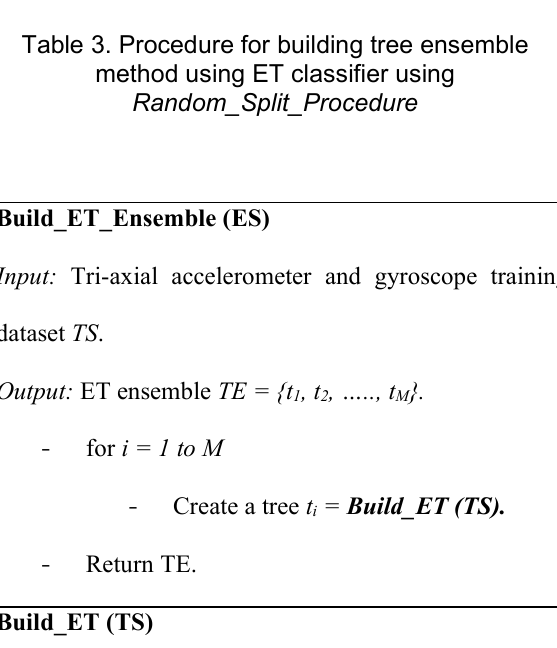
Table 3. Procedure for building tree ensemble method using ET classifier